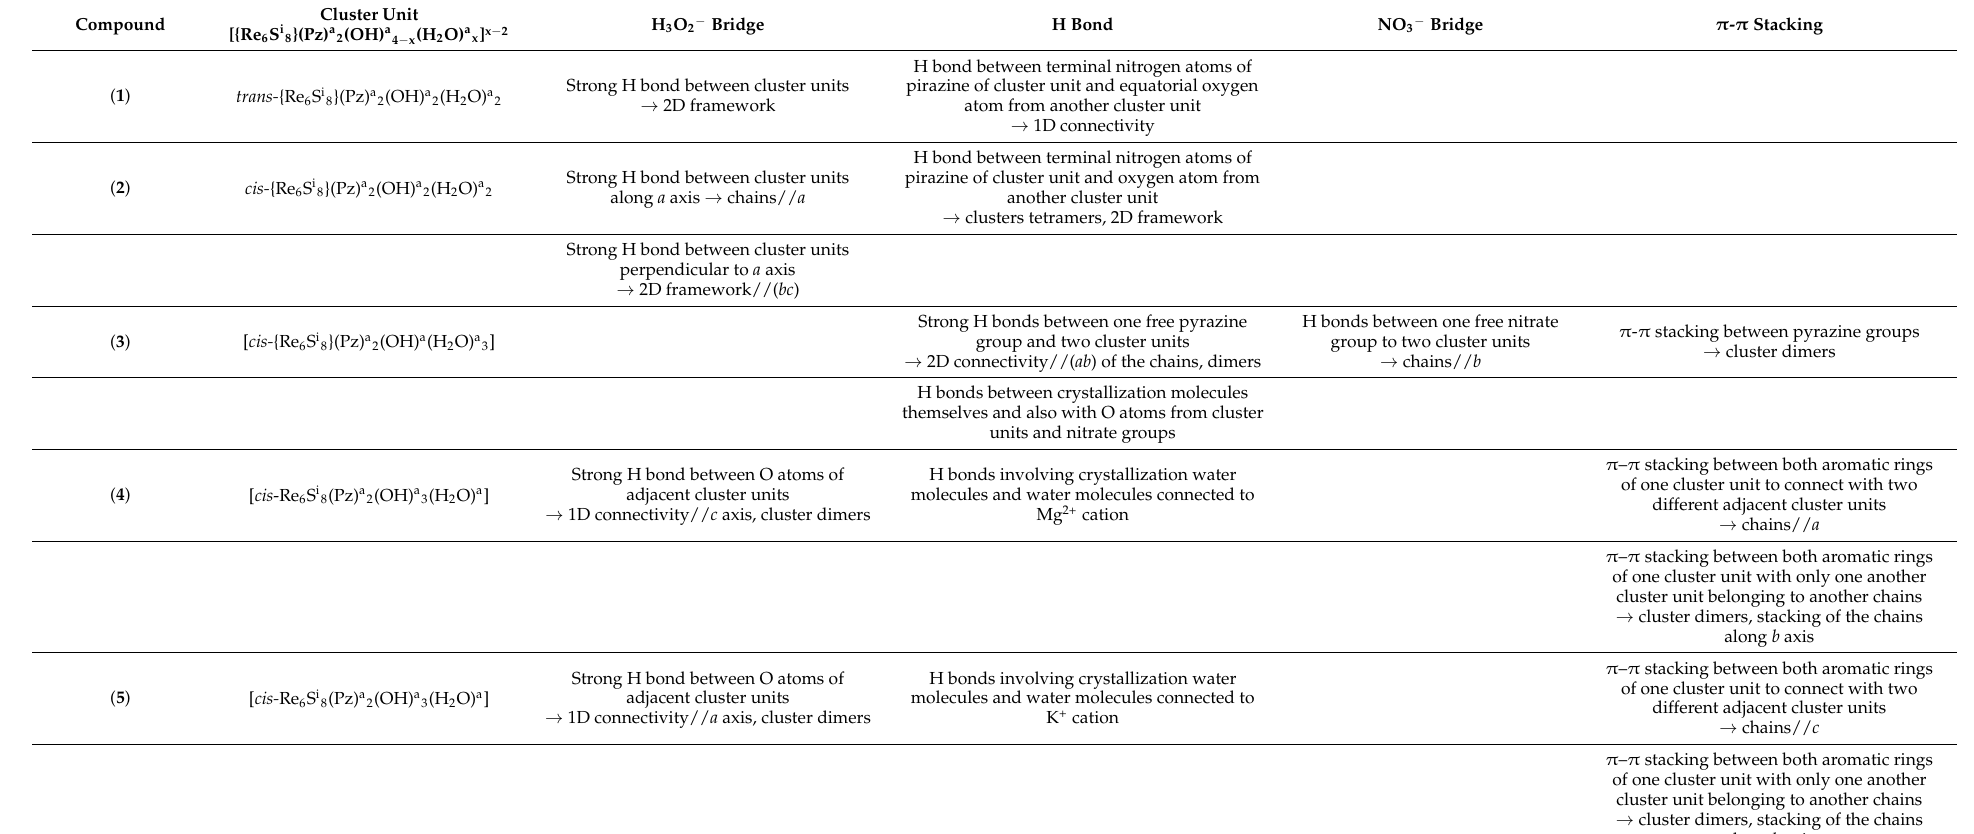
Table 2. Synthons and cluster units based on the {Re 6 S i 8 } core involved in the supramolecular networks of compounds ( 1 )–( 5